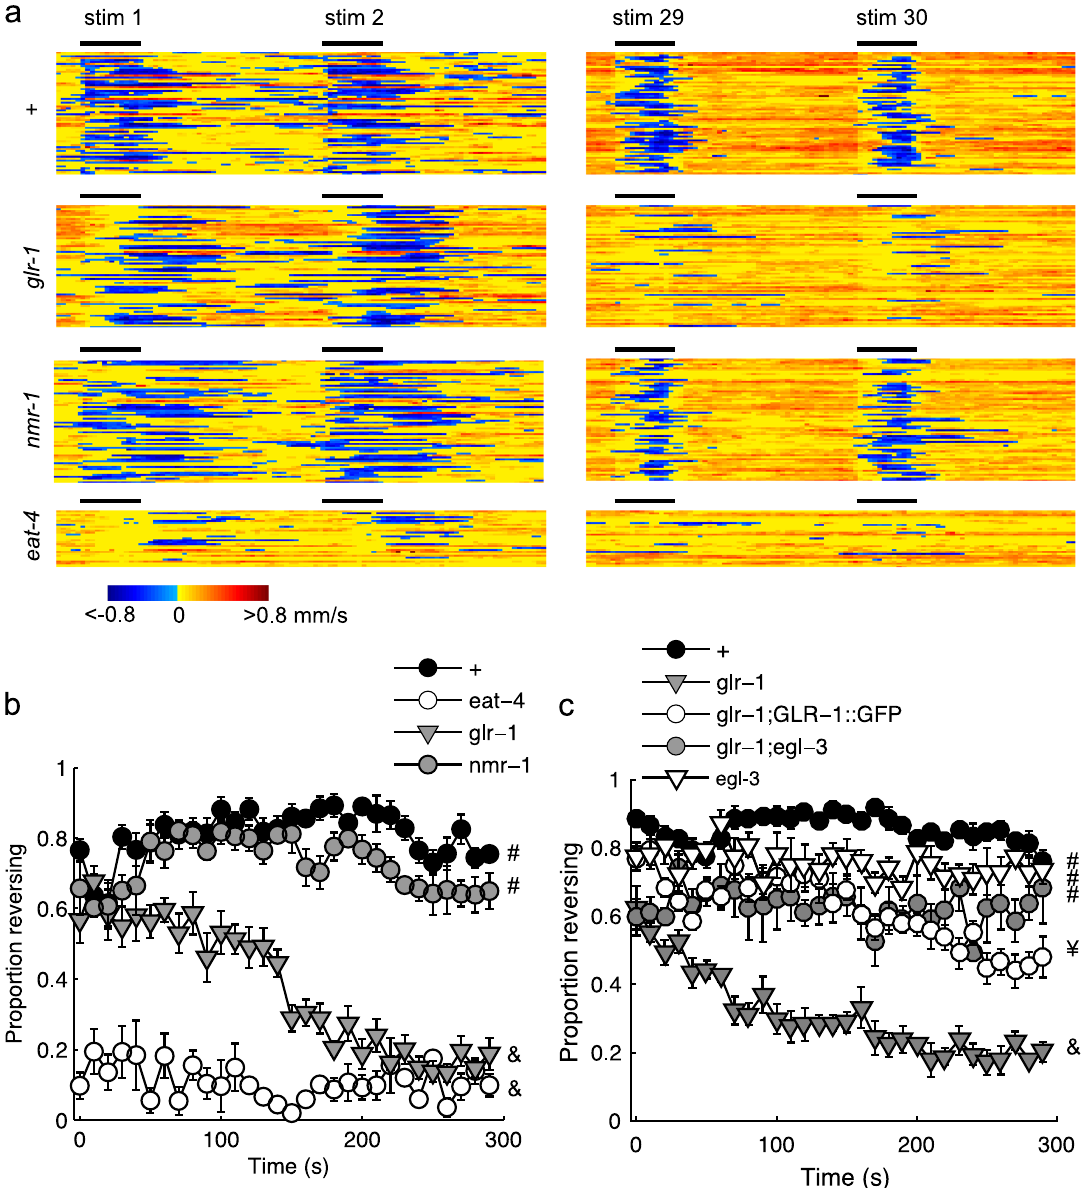
Fig. 1 Habituation of glutamate transmission mutants reveals a glr-1 mutant phenotype. a Representative raster plots depicting the behavioral state at the beginning ( left ) and end ( right ) of training. Pixels are color coded for speed with negative values corresponding to backward locomotion. Black bars indicate 2 s of whole-plate illumination with blue light at 250 μ W/mm 2 . b , c Proportion of the population reversing to each of thirty 2 s light pulses administered at 0.1 Hz. b The glr-1 -independent response did not persist across the assay, c but could be rescued with a GLR-1 expressing transgene (GLR-1::GFP) or suppressed by loss of egl-3 . Mean ± SEM. ‘ # ’ , ‘ ¥ ’ , and ‘ & ’ denote groups that are statistically different based on the likelihood of responding to the fi nal stimulus. N = 6